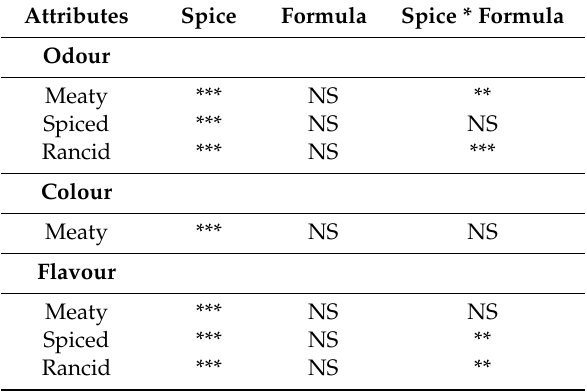
Table 5. General linear model to analyse the e ff ect of spice and formula on sensorial attributes of cooked lamb